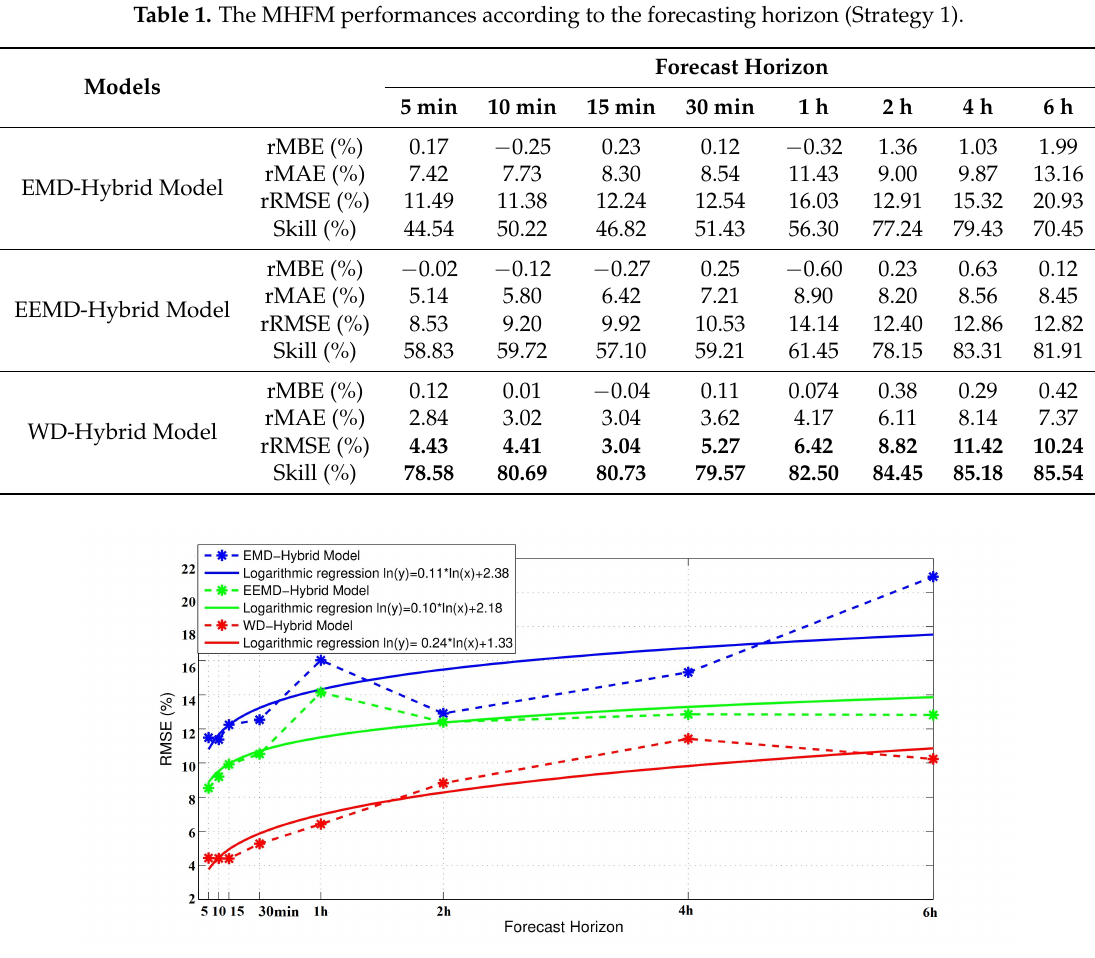
Figure 6. Strategy 1 RMSE error (dotted line) and an attempt of modeling by a logarithmic regression (solid line); in the logarithmic regression equation, y refers to the RMSE and x refers to the forecast horizon τ